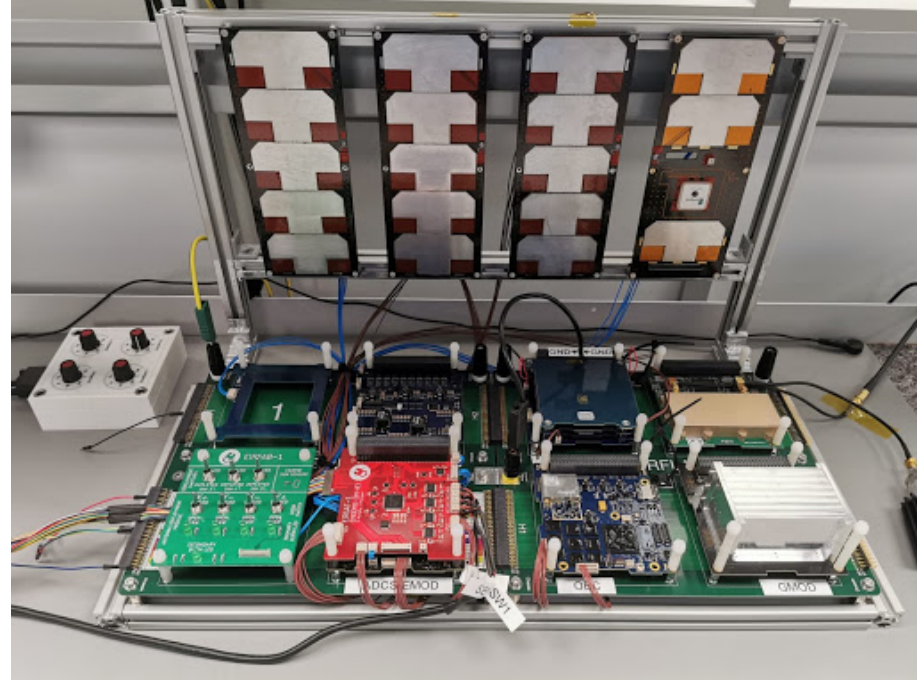
Figure 4. EQM of EIRSAT-1 assembled in the FlatSat level configurations. Note: the EMOD Ther- mal Coupon Assembly and ADM EQMs are not integrated into the FlatSat but represented by dummy equipment.